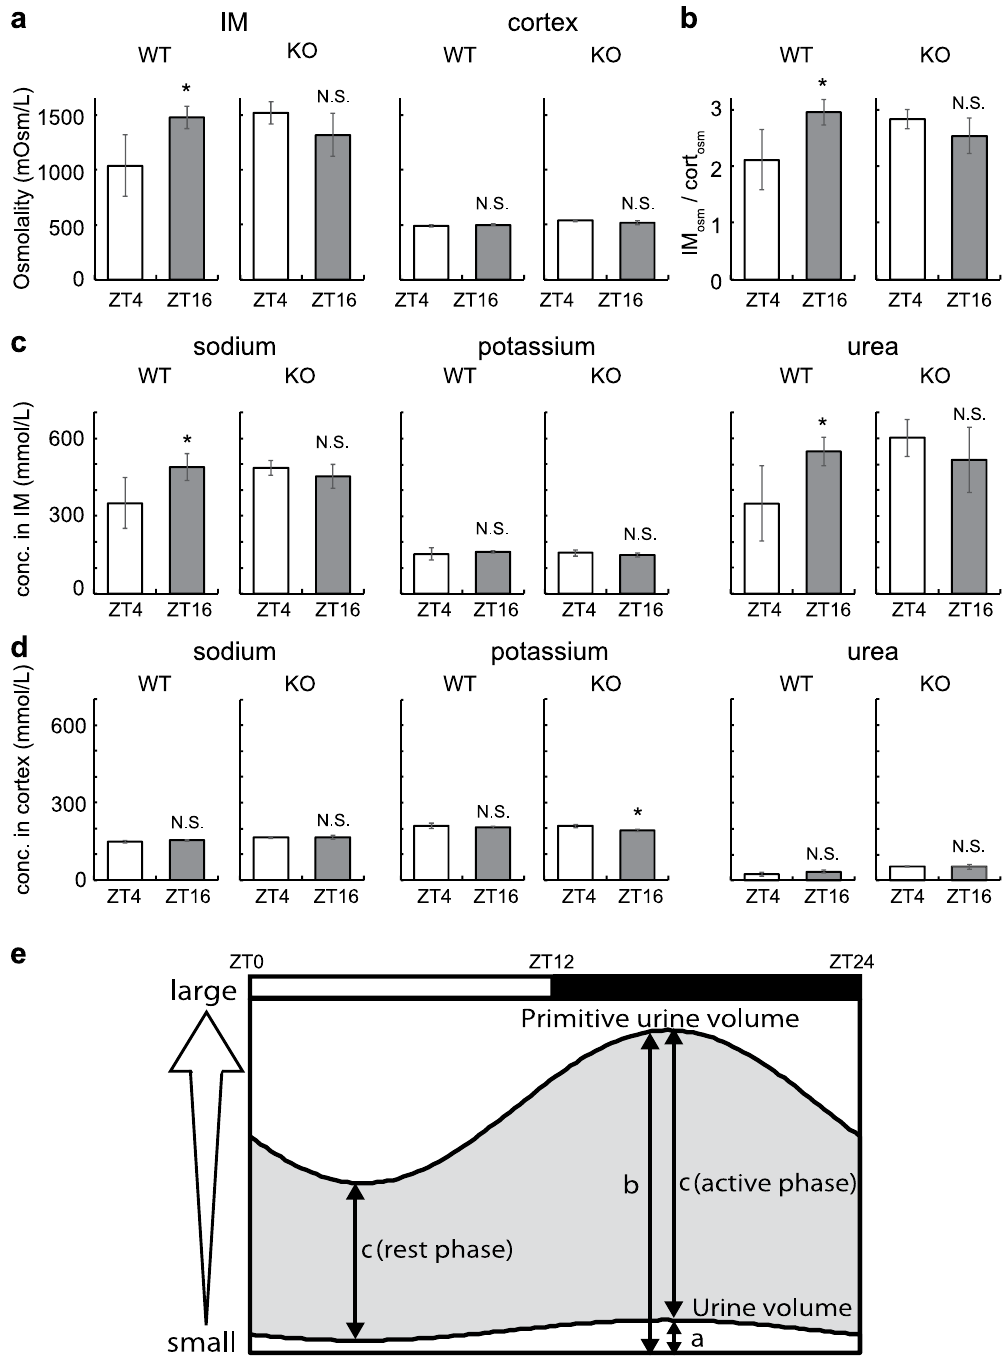
Figure 5. Day-night variations of osmotic pressure, electrolytes, and urea concentrations in wild type and Bmal1 deficient mouse kidney. ( a ) Osmotic pressure in the IM (left) and cortex of the mouse kidney (right). ( b ) IM-cortex osmotic pressure ratio (IM osm /cort osm ) representing osmotic pressure gradient. ( c , d ) Day-night difference of electrolytes and urea concentrations in the IM ( c ) and cortex ( d ). From left to right, day-night difference of sodium, potassium, chloride, and urea concentrations are shown. We used pooled IM and cortex samples from three mice as one sample for measurement and performed four independent experiments. Values are shown as mean values ± S.D. * p < 0.05 versus ZT4. N.S., not significant. ( e ) Schematic view of primitive urine volume and urine volume. a and b denotes urine volume and primitive urine volume, respectively. c denotes water re-absorption volume that equals to difference between primitive urine volume and urine volume (gray shade). Both a and GFR (reflecting in b ) are larger at night 23 . As b is nearly a hundred-times larger than a 50 , circadian variation of b is mainly reflected in the circadian variation of c . Therefore, ( c ) (active phase) is higher than c (rest phase). White and black rectangles in schema indicate the light phase and the dark phase,